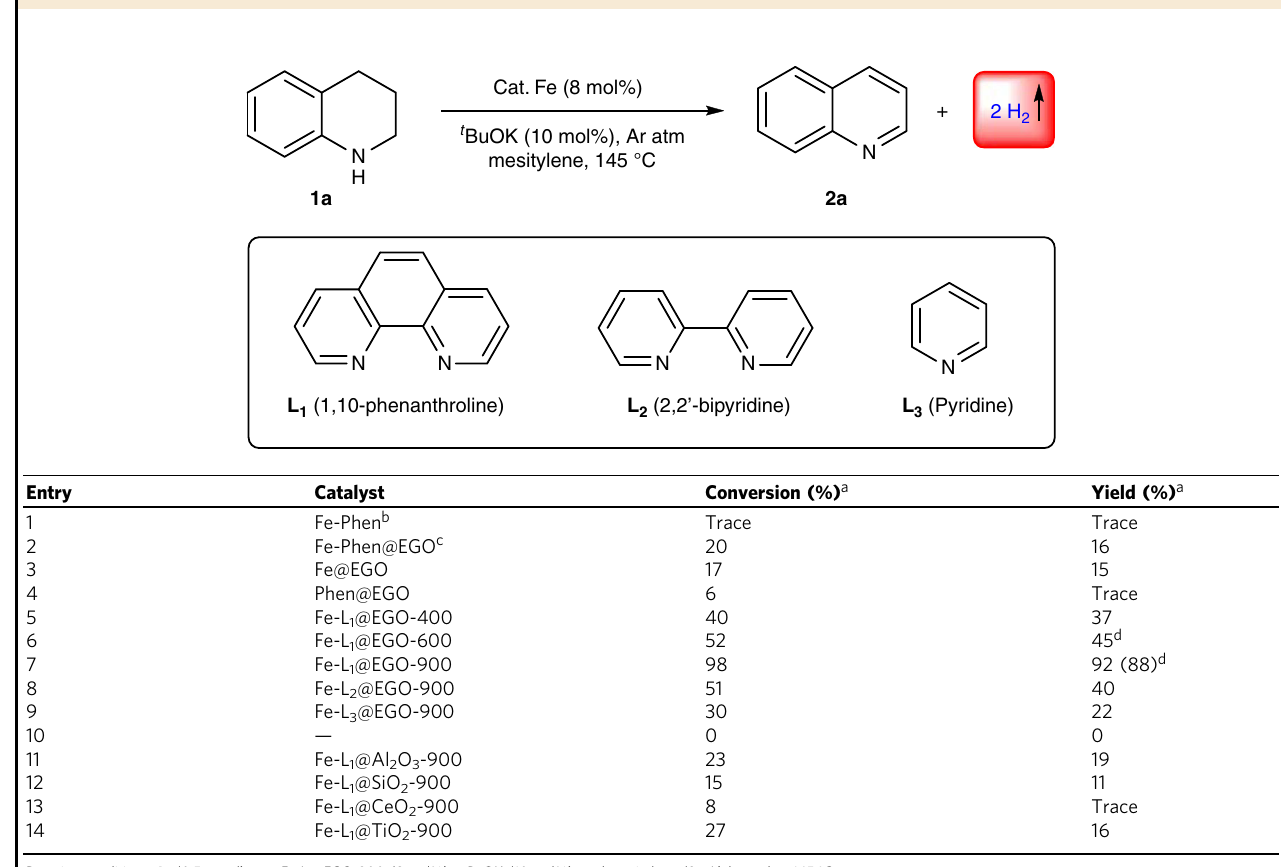
Table 1 Acceptorless dehydrogenation of 1,2,3,4-tetrahydroquinoline (1a)